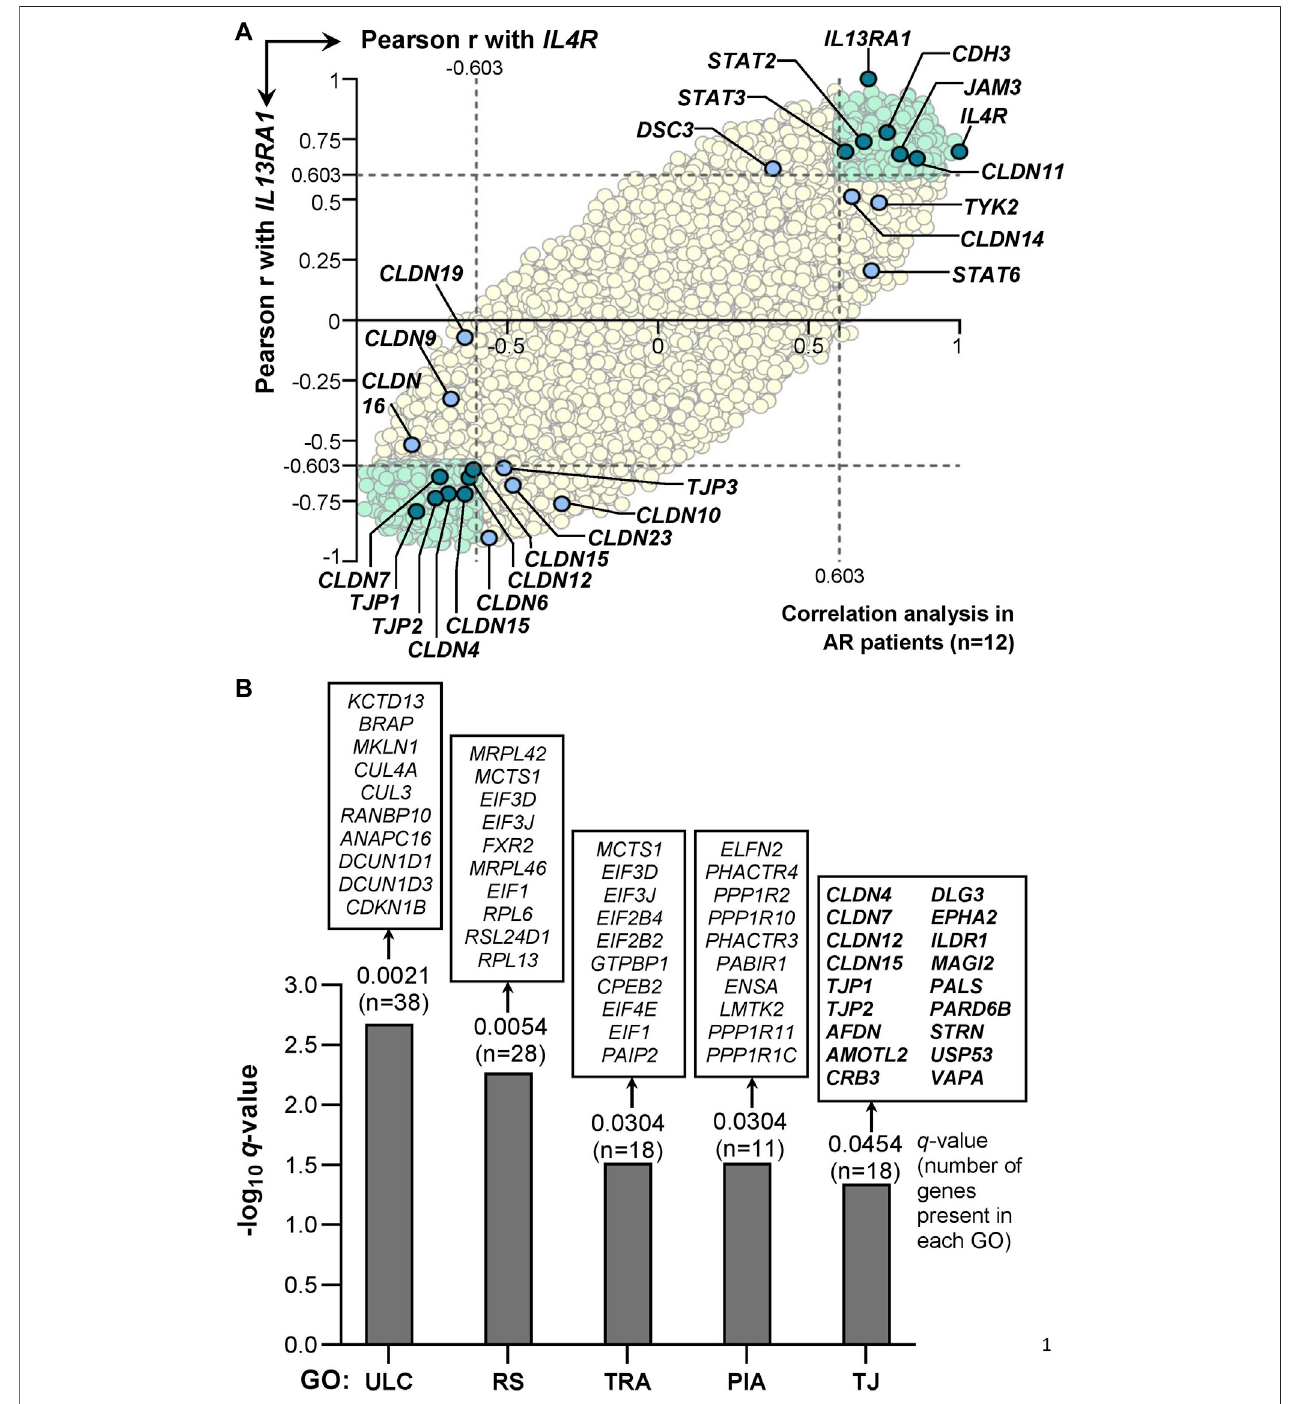
FIGURE 3 | Correlation of IL-4 receptor heterodimer subunits expression ( i.e., IL4R or IL13RA1 ) with 20,541 annotated genes in AR patients derived from GSE44037dataset. (A) Pearsoncorrelation ofthegenesexpression levelswith IL4R or IL13RA1 expression levelsinARpatients( n =12).The Pearsonrvalue±0.603is usedasthecut-off(i.e.thedottedlines)tode fi nepositive(r > 0.603)ornegative(r < − 0.603)correlationwith IL4R or IL13RA1 asthiscut-offrepresentssigni fi cant(i.e. p < 0.05) Pearson correlation for a sample size of 12. All genes signi fi cantly correlated with both IL4R and IL13RA1 expression levels are highlighted in light green. TJ, desmosomal or JAK/STAT signaling genes with signi fi cant correlation with both IL4R and IL13RA1 expression levels are highlighted in teal. TJ, desmosomal or JAK/ STAT signaling genes with signi fi cant correlation with either IL4R or IL13RA1 expression levels only are highlighted in light blue. The rest of the background genes are highlighted in yellow. (B) Gene Ontology (GO) enrichment analysis of genes inversely associated with IL4R and IL13RA1 expression (GSE44037 dataset). Ten representativegenesaredisplayed ontopofeach bar,and all18genescontributedtotheenrichment ofTJontology(GOID:0070160)areshown.ULC:Ubiquitinligase complex; RS: Ribosomal subunit; TRA: Translation regulator activity; PIA: Phosphatase inhibitor activity; TJ: Tight junction.